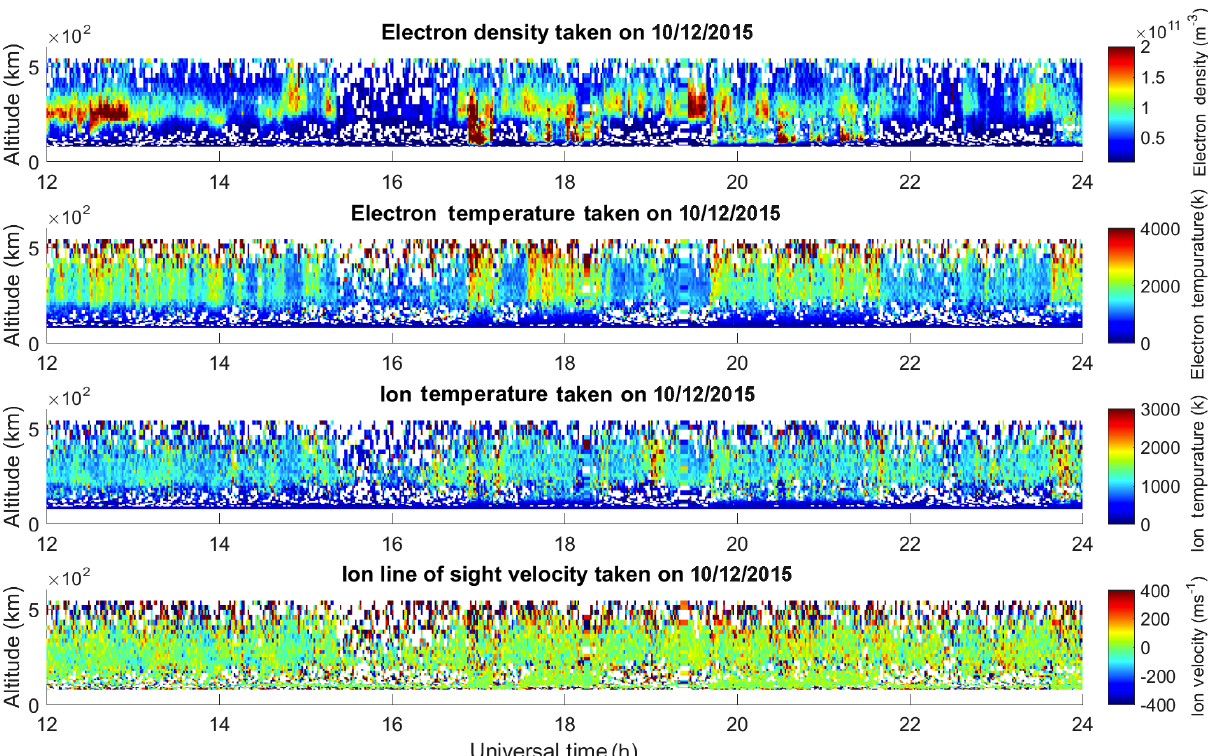
Figure 8. Electron densities, electron temperatures, ion temperatures, and ion drift line of sight velocity measured by the 42m dish of the ESR observing at an azimuth of 184.5 ◦ and an elevation of 81.6 ◦ between 12:00 and 23:59UT on 10 December 2015.